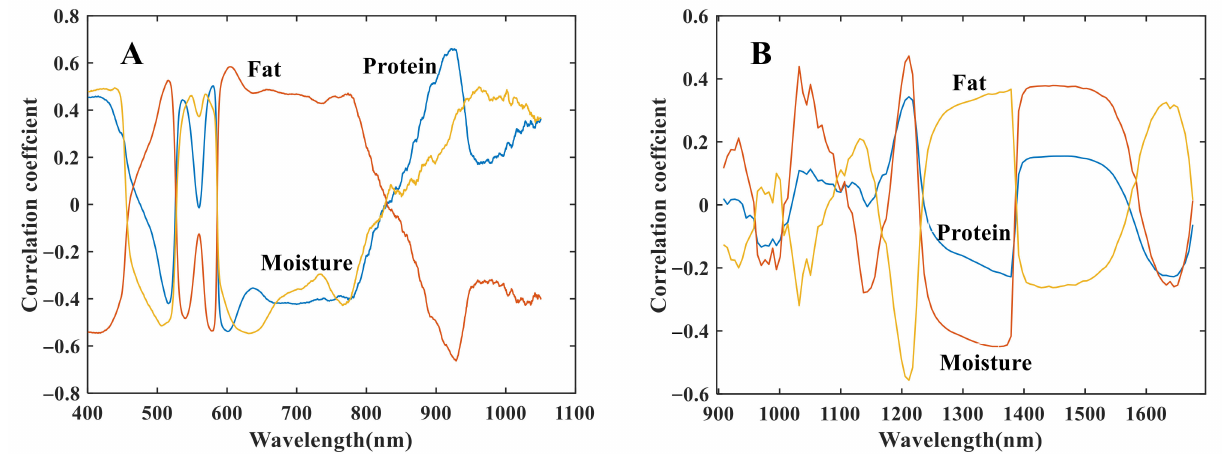
Figure 2. Correlation coefficients between raw spectral data and measured values of fat content, protein content, and moisture content: ( A ) showed the correlation coefficients between data in 400–1050 nm region and measured value of quality parameters; ( B ) showed the correlation coefficients between data in 900–1700 nm region and measured value of quality